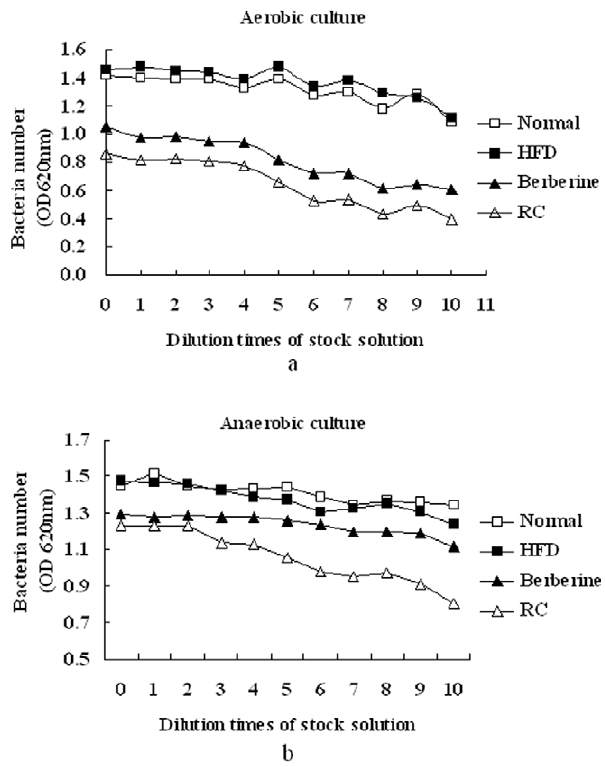
Figure 3. Effects of RC and berberine on growth of fecal bacteria ex vivo under (a) aerobic and (b) anaerobic condi- tions. ‘‘Normal’’, normal chow diet-fed mice; ‘‘HFD’’, high-fat diet-fed control mice; ‘‘Berberine’’, Berberine-treated HFD mice; ‘‘RC’’, Rhizoma Coptidis-treated HFD mice (n=6).